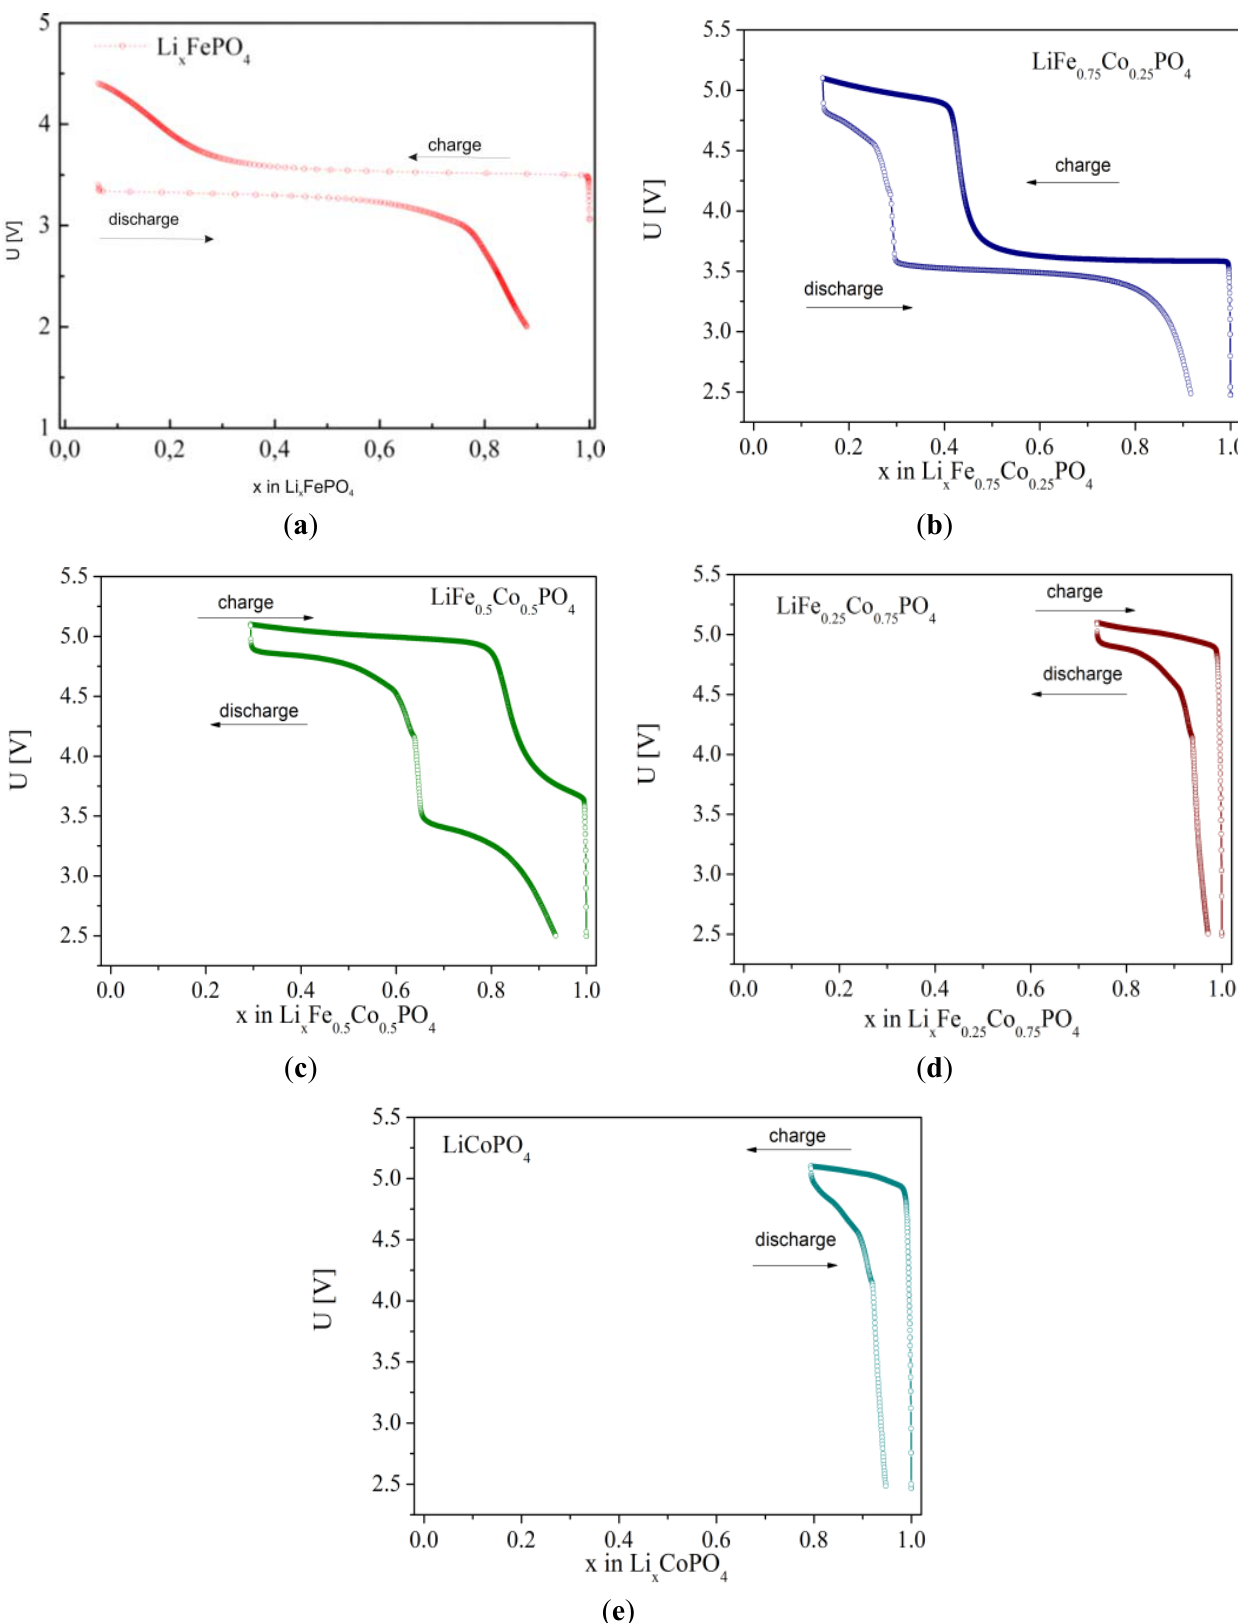
Figure 30. Charge/discharge curves for Li/Li + /Li speed for materials with: ( a ) y = 0; ( b ) y = 0.25; ( c ) y = 0.5; ( d ) y = 0.75 and ( e ) y =